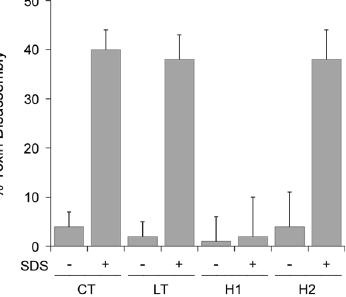
Figure 3. Comparative analysis of CT/LT stability. The indicated toxins were appended to the wells of a GM1- coated ELISA plate and exposed to pH 5.5 medium in the absence or presence of 0.1% SDS for 30 min at 25 °C. After extensive washing, sequential incubations with primary and HRP-conjugated secondary antibodies were used to detect the A1 subunit. The percentage of toxin disassembly was calculated from the maximum A1 signal obtained from the corresponding untreated holotoxin. H1 is a hybrid toxin that was previously thought to mimic native CT 13 ; H2 is a hybrid toxin that was previously thought to mimic native LT 13 . Error bars present the standard error of the means from five independent experiments with six replicate wells per